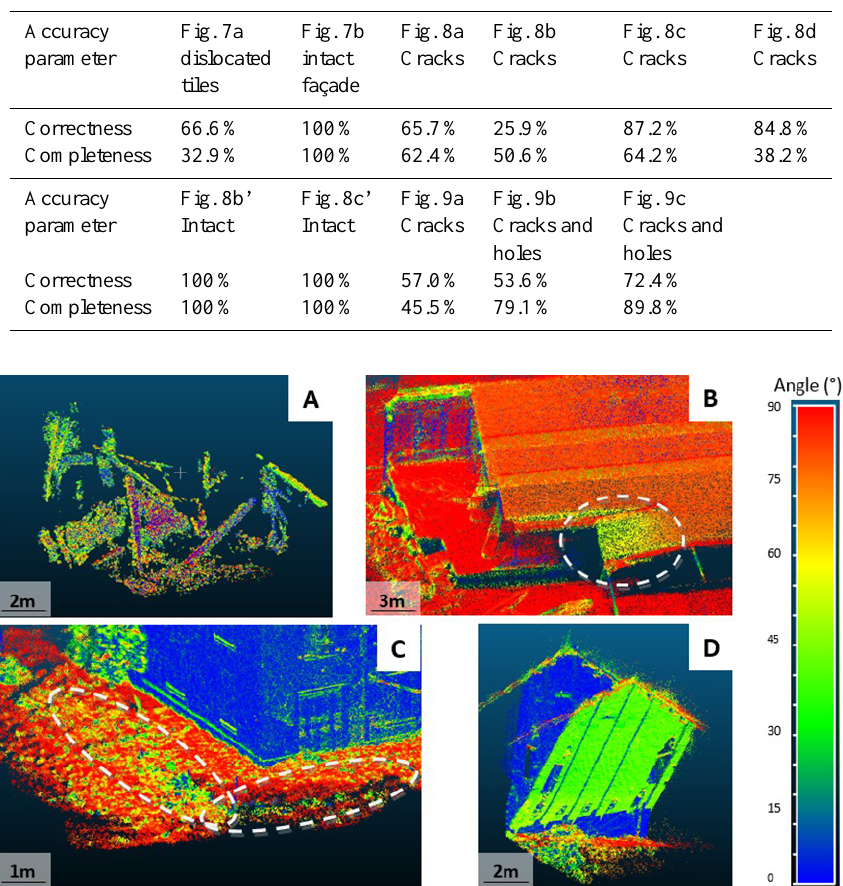
Figure 6. Z component visualization of target damage features: (a) collapsed building, (b) partially collapsed roof (outlined in white), (c) rubble pile (outlined in white), and (d) vertical façade (blue) compared to a simulated inclined façade (green). Scale approx.